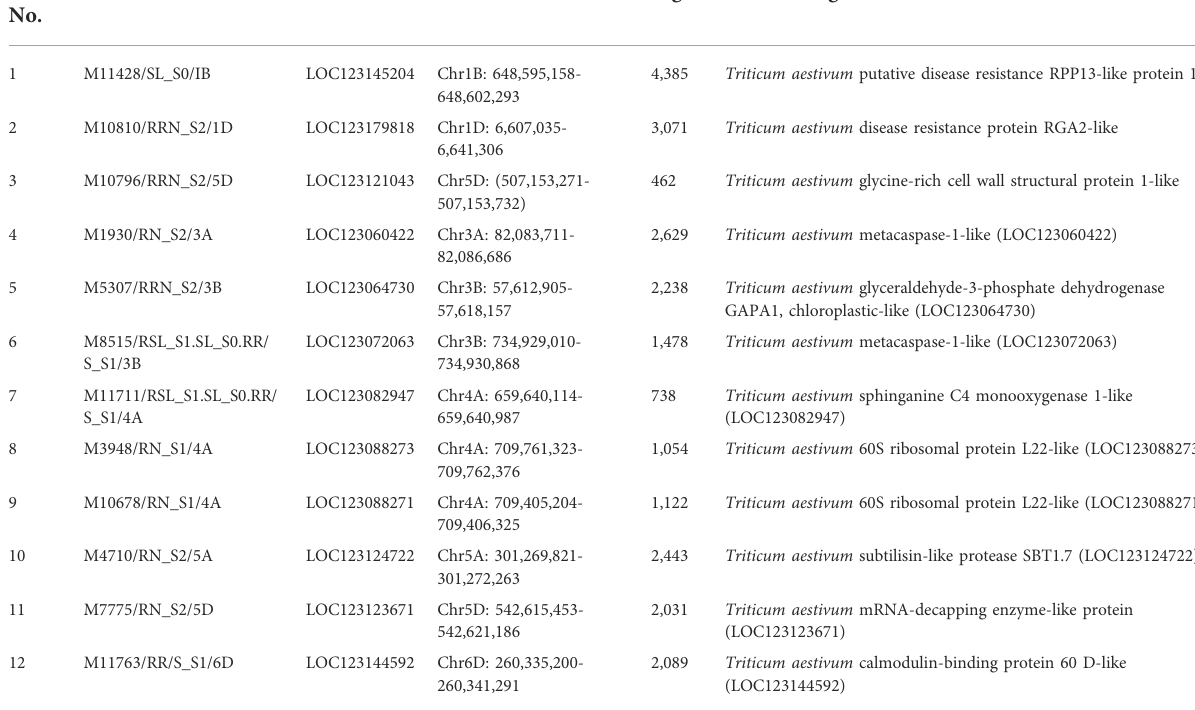
TABLE 3 Identi fi cation of candidate genes involved in stress tolerance. Sr.